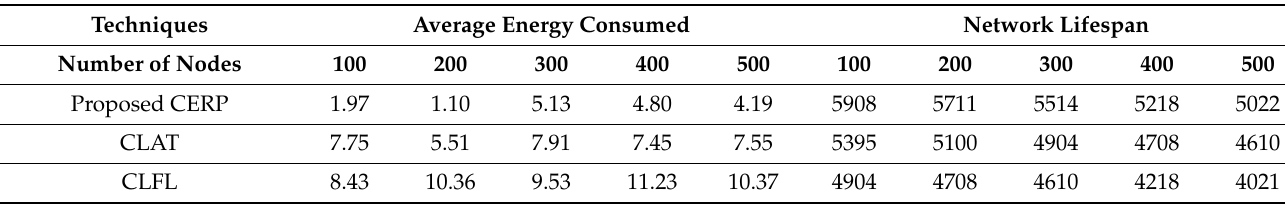
Table 4. Energy consumption and network lifespan.